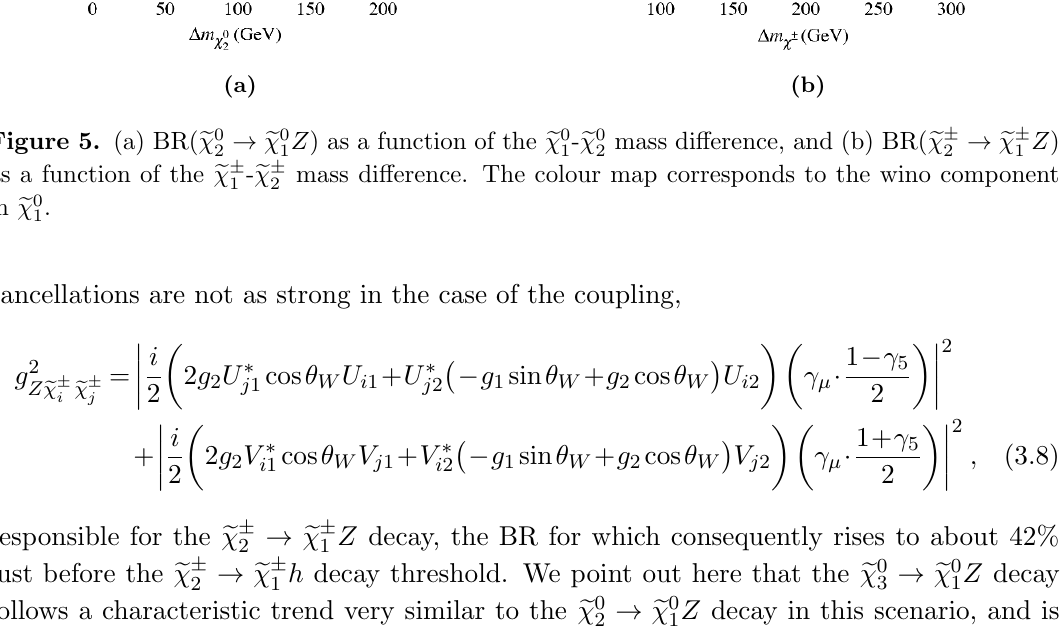
(cid:31) 0 - (cid:31) 0 mass di(cid:11)erence, and (b) BR( e e 1 2